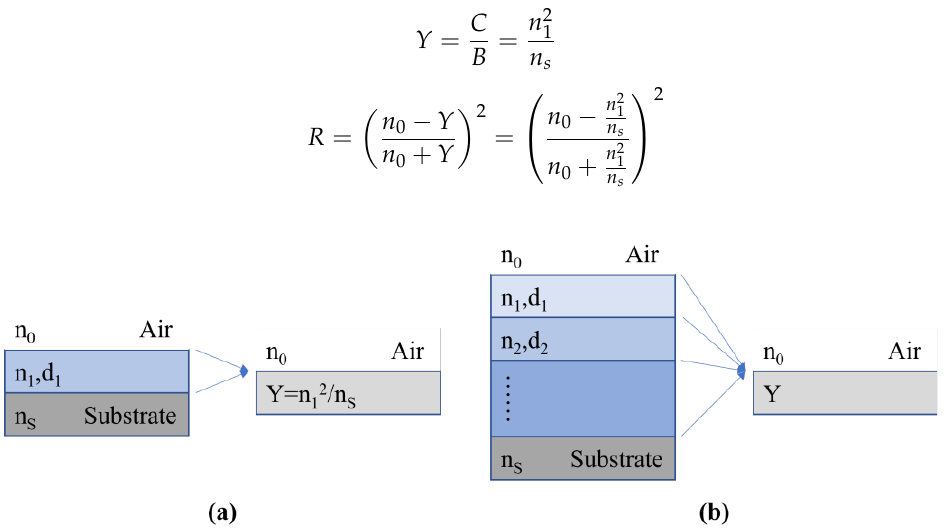
Figure 1. The structures and equivalent interfaces of the ( a ) monolayer film and ( b ) multilayer film. When the refractive indices satisfy: